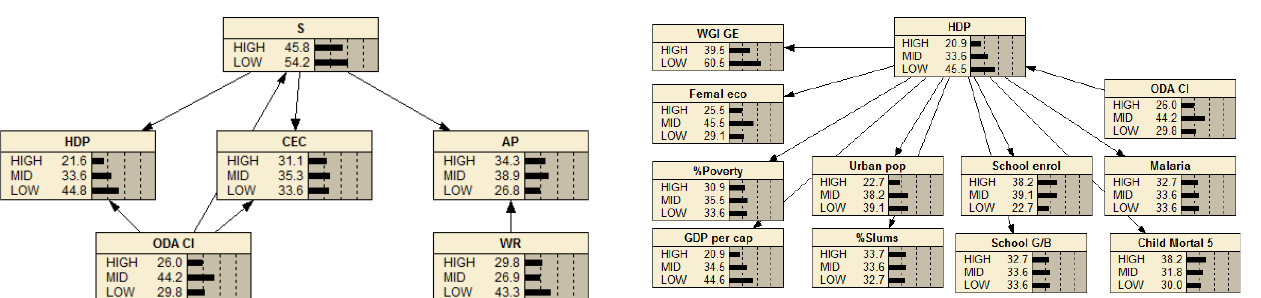
Fig. 3. S general model, DAG shows the relationships between the S and pillars.